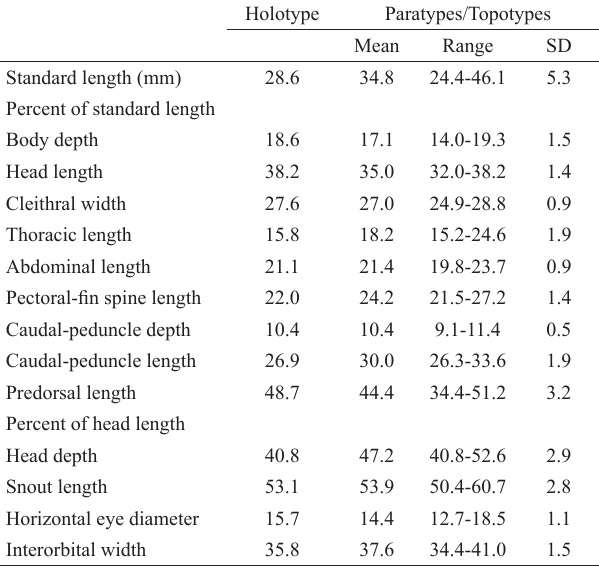
Table 1. Morphometric data of Parotocinclus spilurus